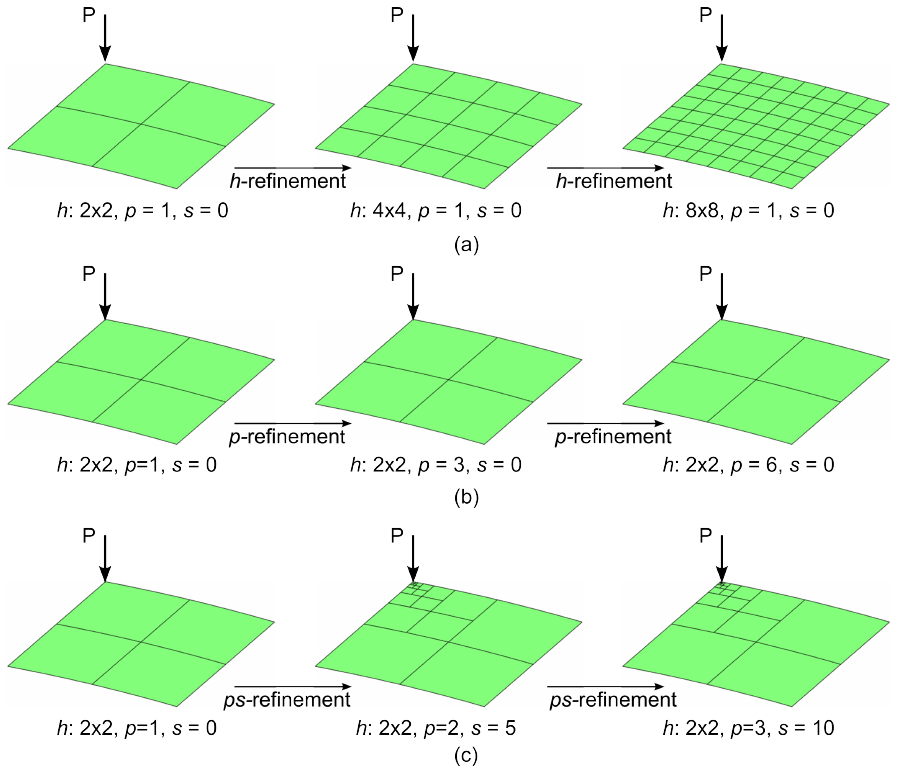
Figure 23. Cylindrical panel: refinement strategies: ( a ) h , ( b ) p , ( c ) ps − linear. Table 8. Summary of the refinement parameters of the FE models used for solving the application example